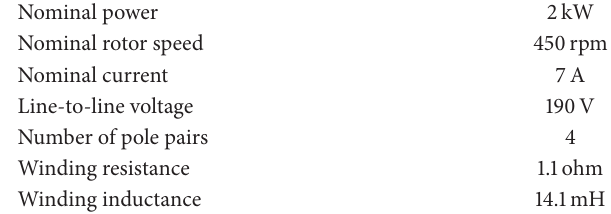
Table 2: PMSG parameter.